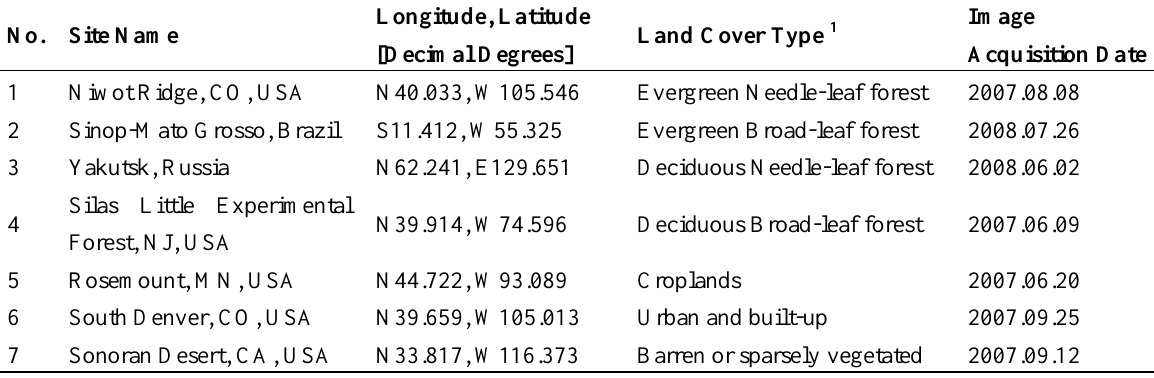
Table 1. FLUXNET sites used in ASTER and MODIS EVI compatibility